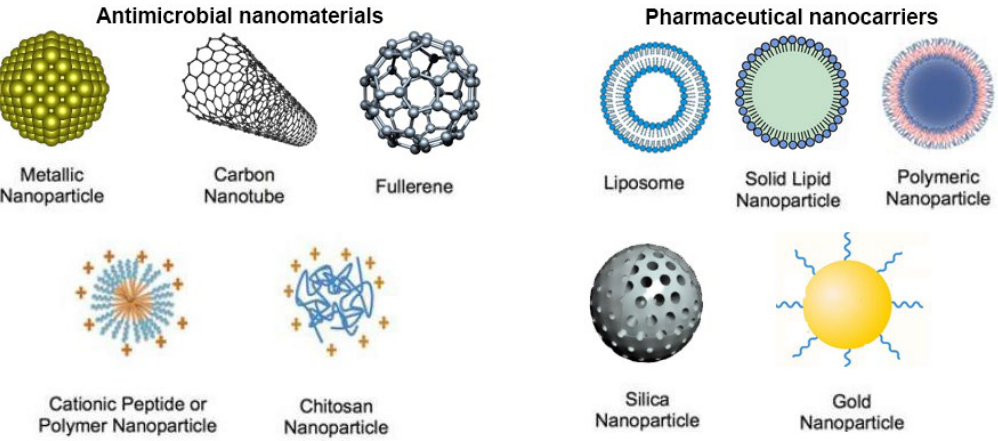
Figure 5. Antimicrobial nanomaterials and nanoparticle-based drug delivery systems: A schematic overview.